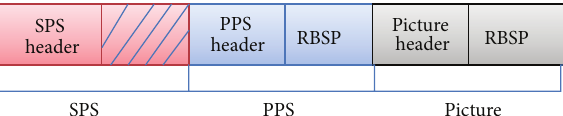
Figure 8: Encrypted part by proposed technique.